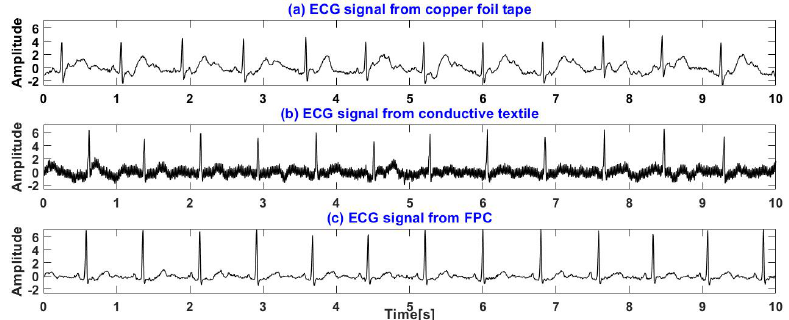
Figure 14. ECG signals of a subject sitting on a chair: ( a ) ECG signals measured by copper foil tape. ( b ) ECG signals measured by conductive textile. ( c ) ECG signals measured by